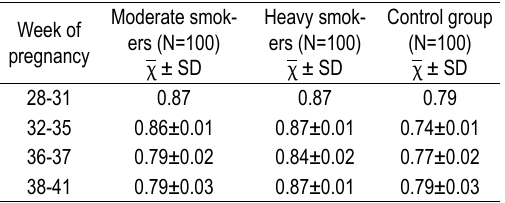
Figure 2. Mean values, standard deviations, and